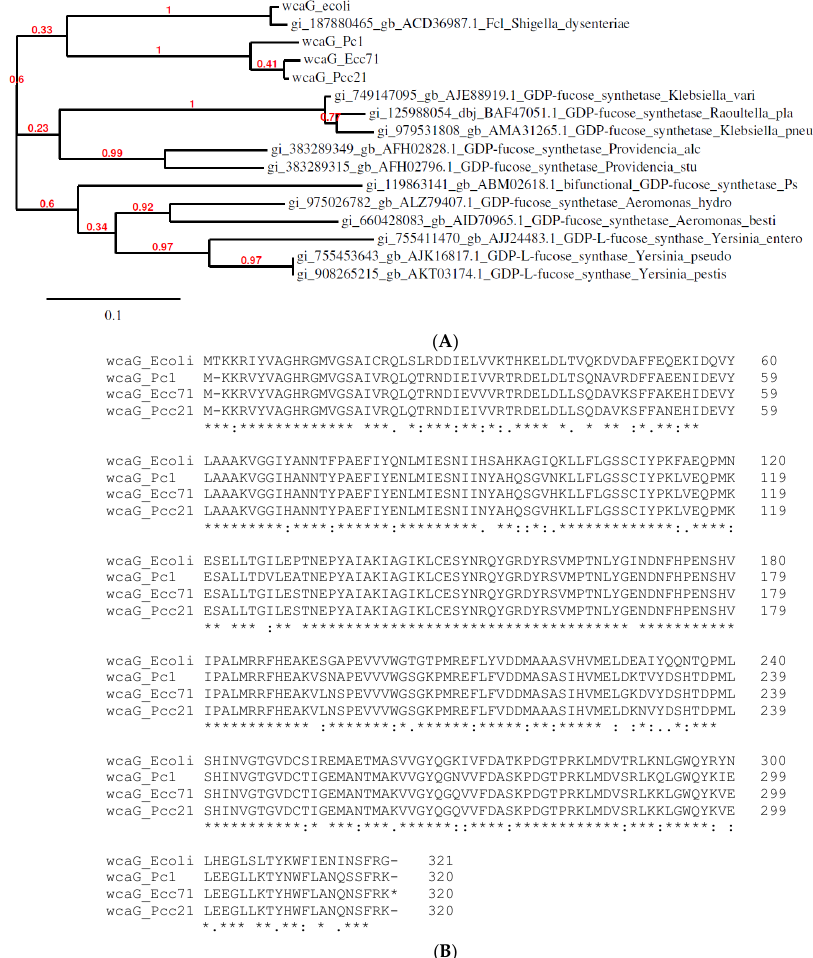
Figure 5. ( A ) Phylogenetic tree of predicted P. carotovorum Ecc71 WcaG with other Enterobacteriaceae family members. The phylogenetic tree reveals that the WcaG protein of Escherichia coli is evolutionarily close to those from Pectobacterium species. ( B ) Multiple sequence alignment of WcaG protein sequences from Escherichia coli and Pectobacterium strains. The alignment was made with deduced amino acid sequences of WcaG of P. carotovorum Ecc71 and its homologs from strains PC1, PCC21 and Escherichia coli K12. The alignment reveals almost similar or identical deduced amino acid